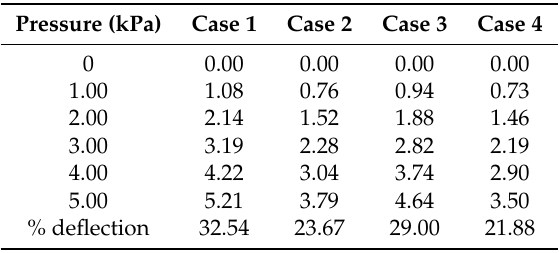
Figure 4. Simulated diaphragms with center deflection at 5 kPa. Table 1. Pressure versus center deflection for the four design cases.